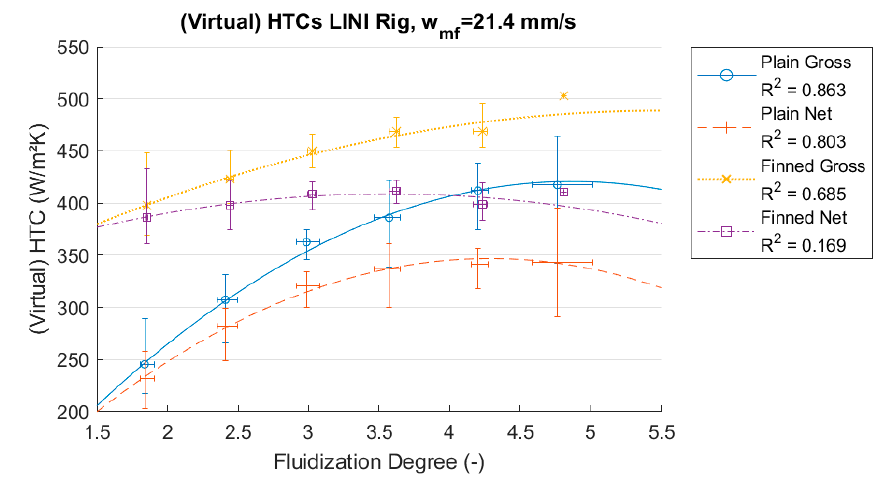
Figure 11. Results of the LINI test rig, plain and finned tubes, 146 µm particles.